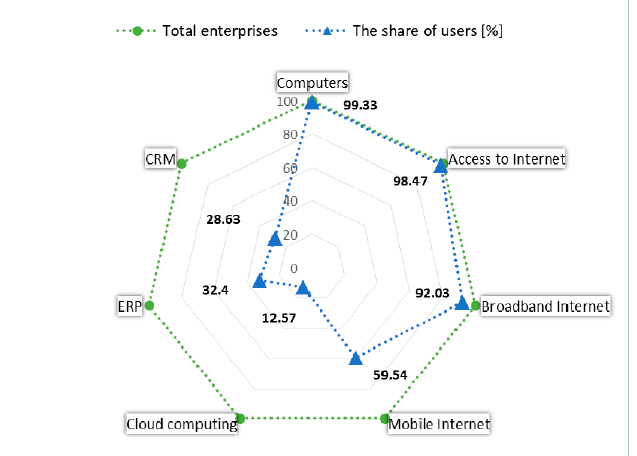
Figure 1. ICT in the steel industry (manufacturers of basic metals) in Poland. Source: Data from GUS [122].